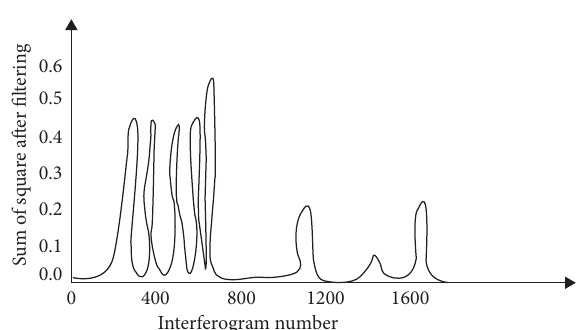
Figure 4: The modulation intensity of the SF6 interference figure dataset in the interval between 175 and 250 after FIRM filtering (the peak value is the SF6 signal, and the baseline is the background